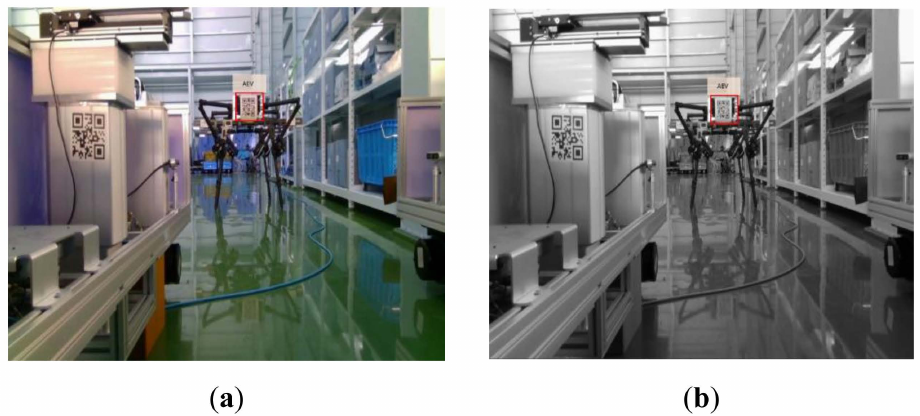
Figure 11. AEV’s marker recognized from the mobile station. ( a ) RGB color Image, ( b ) Gray color Image.